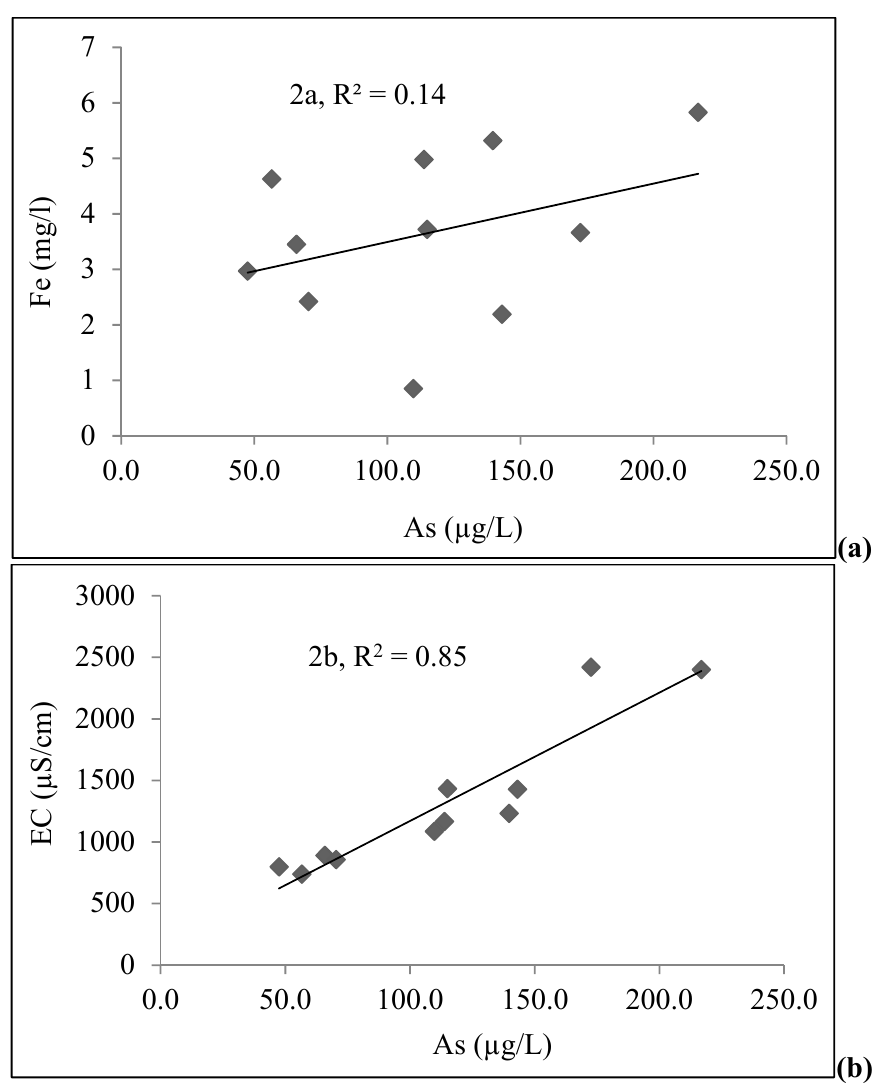
Figure 2. Correlations of arsenic with ( a ) iron, ( b ) EC, ( c ) phosphate and ( d ) Eh in groundwater of shallow tube wells (upper aquifer) in